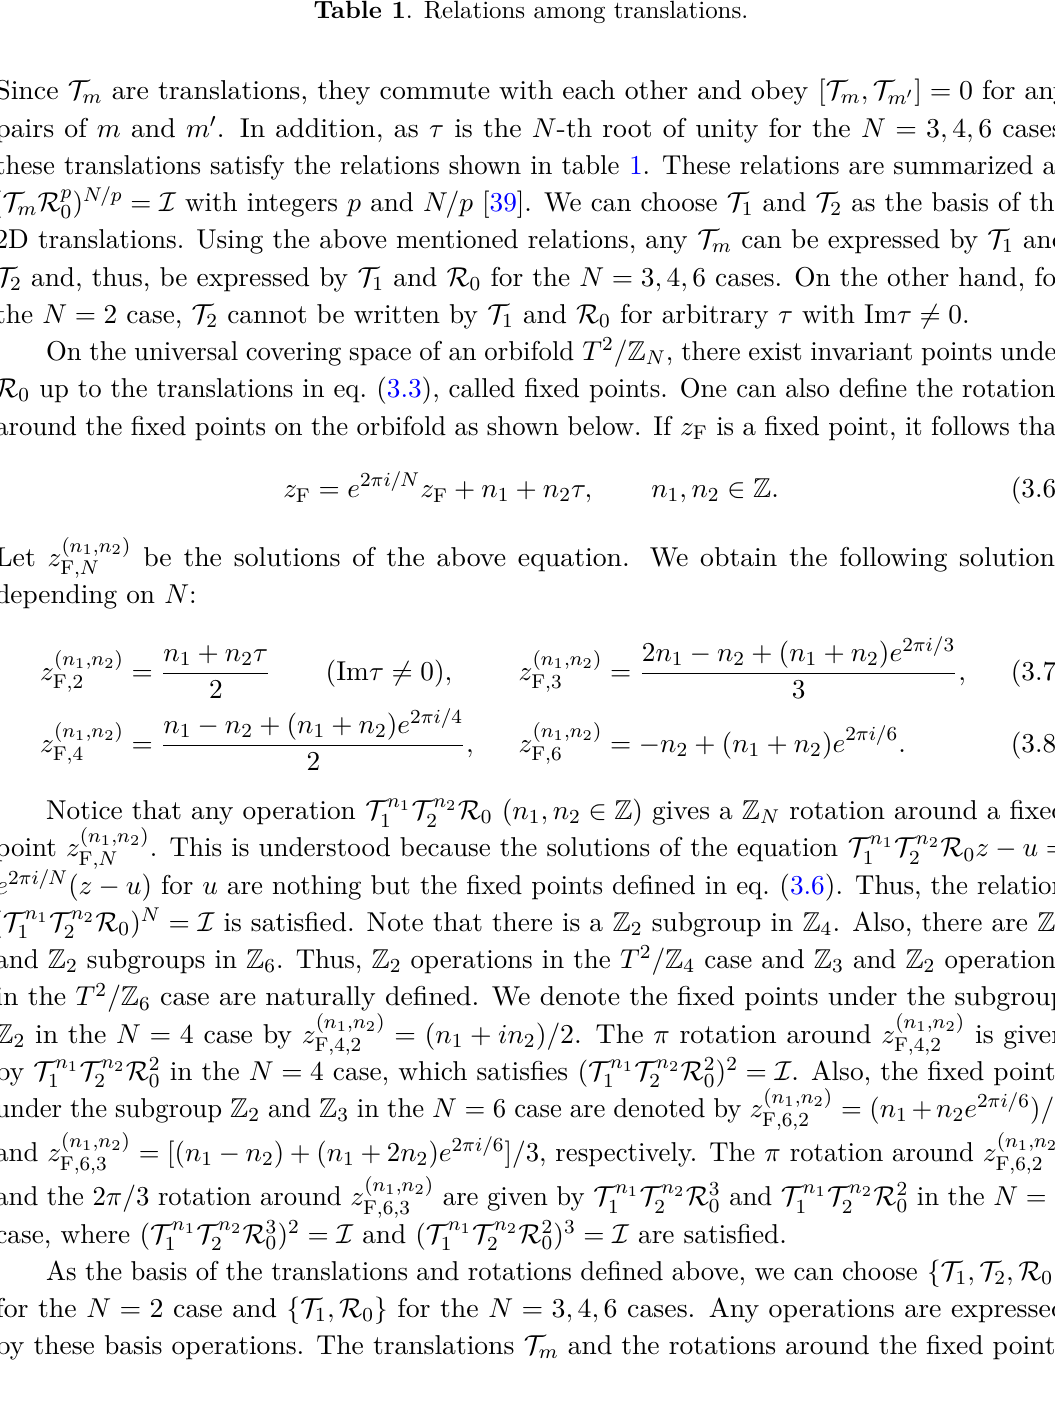
Table 1 . Relations among